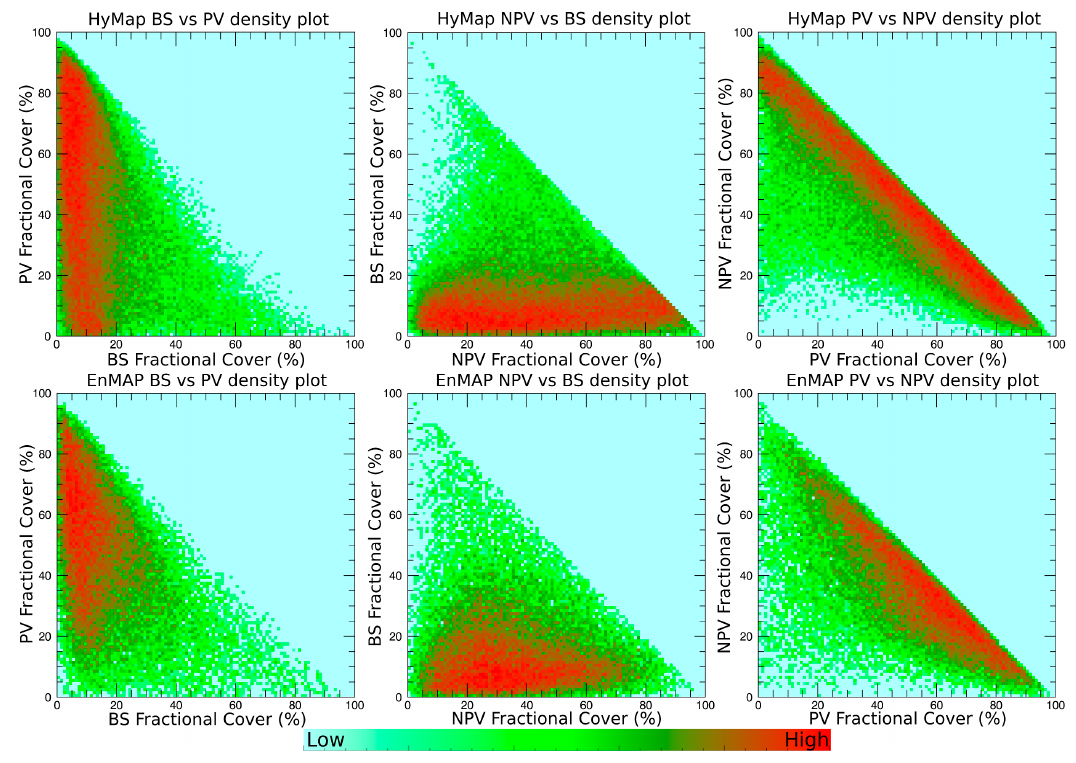
Figure 6. Density scatterplots showing mixing relationship between the classes BS, PV and NPV fractional cover for HyMap and